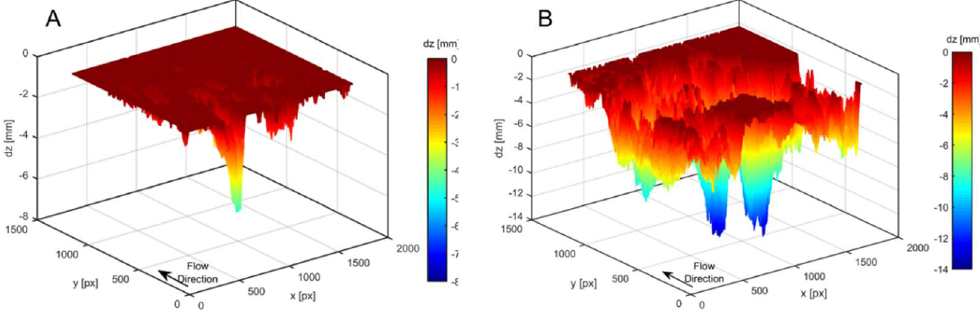
Figure 6. Three-dimensional plots of the sediment surfaces at the end of the erosion experiments after t = 600 s for Q 1 = 7.5 L/s ( A ) and Q 2 = 11.3 L/s ( B